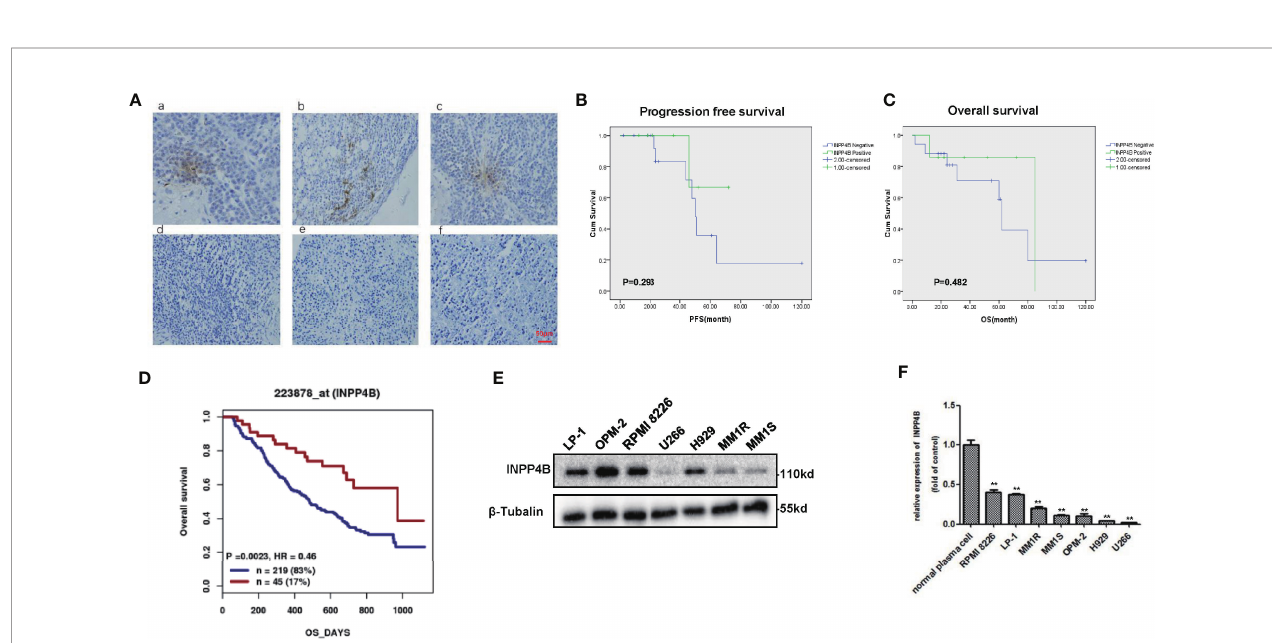
FIGURE 2 | Expression of INPP4B in EMP samples and cell lines. (A) Immunohistochemical images of EMP tissue (focal positive: a, b, c; negative: d, e, f). Scar = 50 m m. (B) Patients strati fi ed according to their INPP4B expression level (positive and negative) and correlation of INPP4B expression with progression-free survival (PFS). (C) Overall survival (OS) rate of patients with these extramedullary involvements. (D) Correlation of INPP4B expression and overall survival rate of MM patients in GSE7982 cohort. (E) INPP4B protein expression in various multiple myeloma cell lines. (F) INPP4B mRNA expression in various multiple myeloma cell lines. Data are plotted as mean ± SD from three independent experiments (** p < 0.01, vs. the